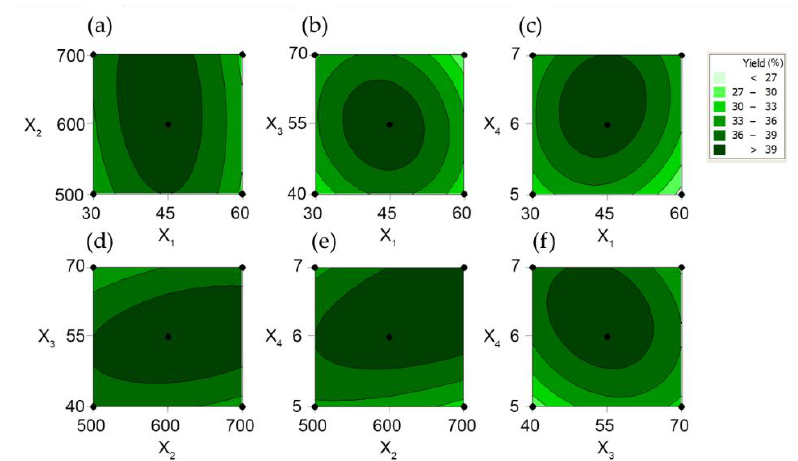
Figure 2. Response surface (3D) showing the effects of variables on the yield of ulvan. Effects of ( a ) extraction time (X 1 ) and power (X 2 ), ( b ) extraction time and water-to-raw-material ratio (X 3 ), ( c ) extraction time and pH (X 4 ), ( d ) power and water-to-raw-material ratio, ( e ) power and pH, ( f ) water- to-raw-material ratio and pH on ulvan yield (Y, %).